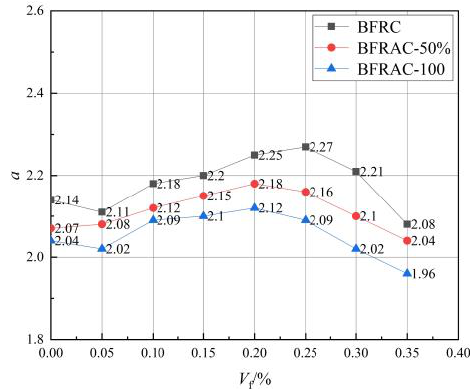
Figure 19. a -value change curve of BFRAC.